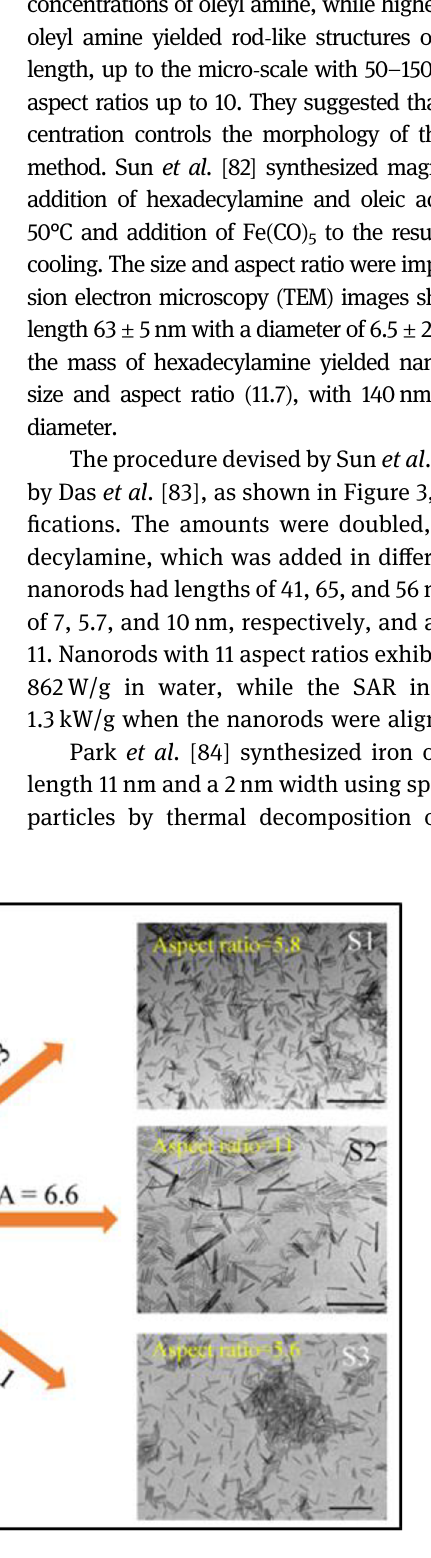
Figure 3: Scheme for the synthesis of magnetite nanorods with tunable aspect ratios. Nanorods are monodispersed in A in the absence of a magnet, while B shows the same nanorods with an external magnet [ 83 ]